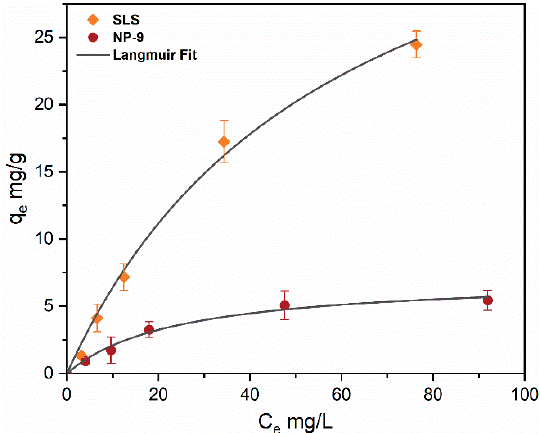
Figure 2. Isotherm modeling (0–100 mg/L) of SLS and NP-9 surfactants onto CuO NPs (50 mg/L) at pH 7.